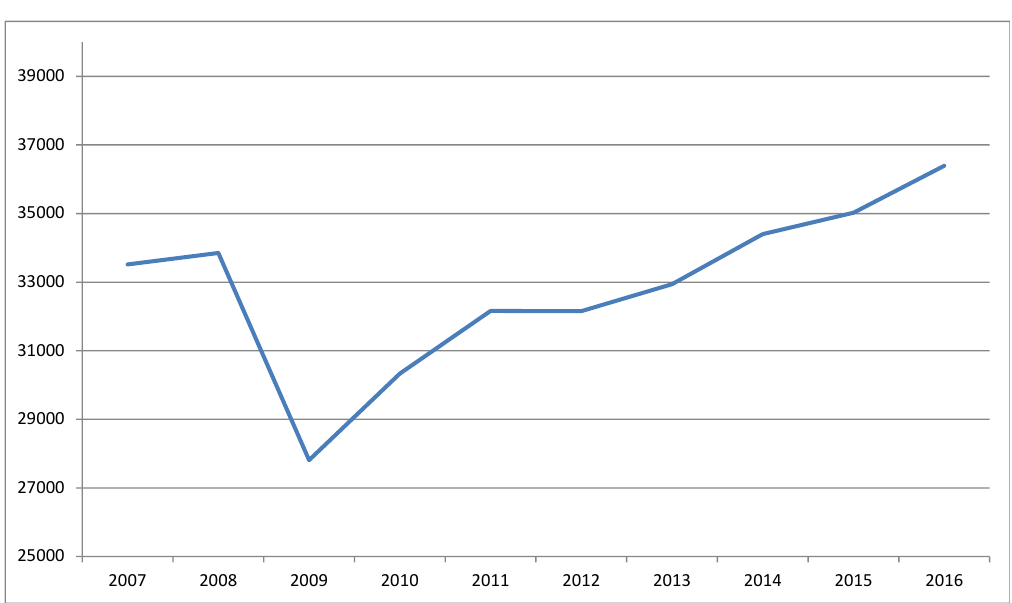
Figure 1: Manufacturing and Equipment Value Added per Capita in Italy (Euro)